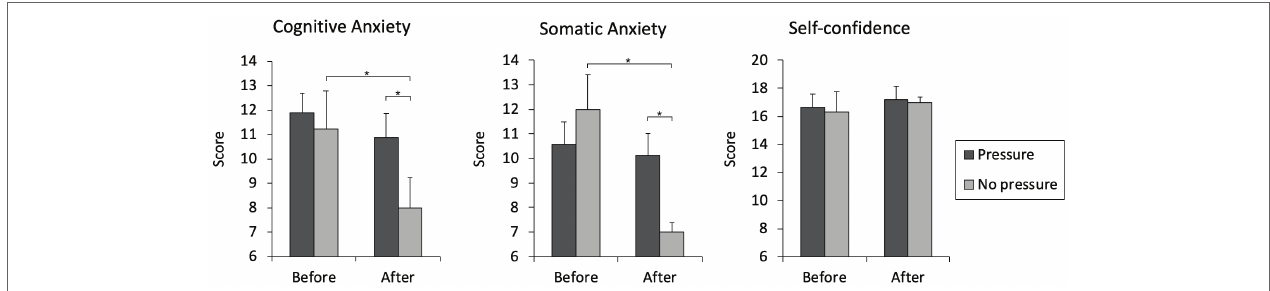
FIGURE 2 | Scores of CSAI-2R of the players before and after performing the penalty kicks. * p <